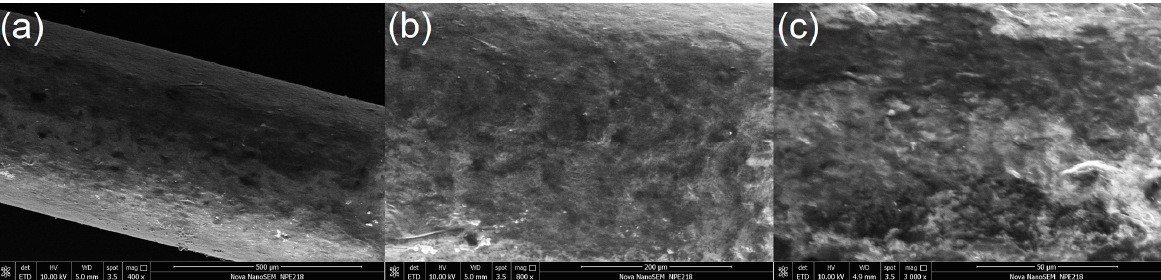
Figure 2. SEM images of the GO-PAN@PNE fiber in different magnifications: ( a ) 400 × ; ( b ) 800 × ; ( c ) 3000 ×